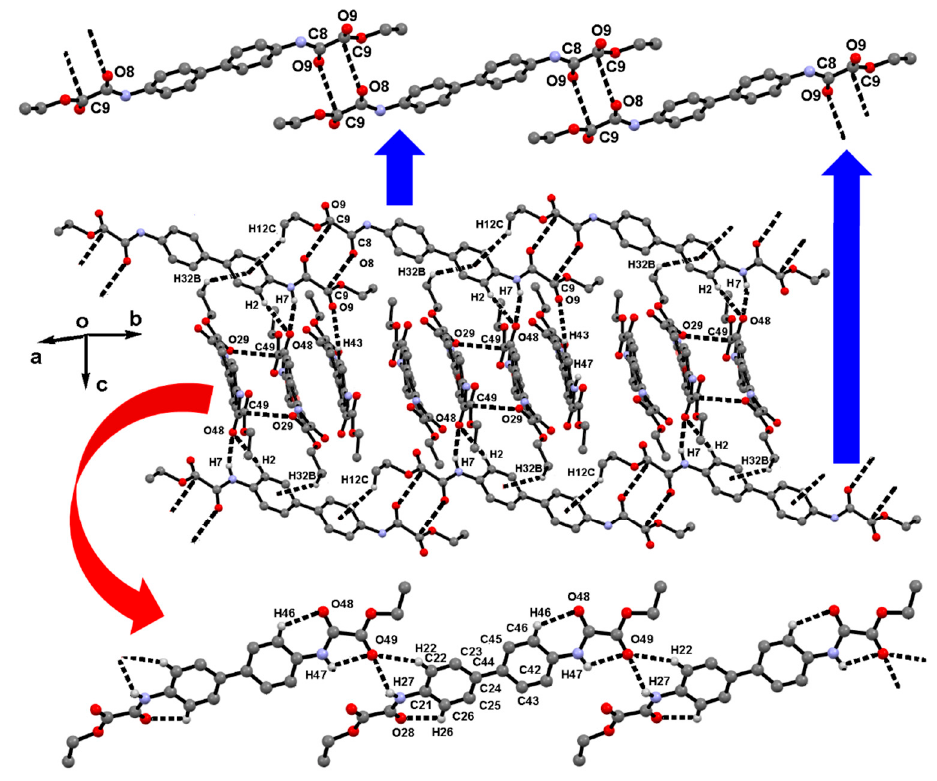
Figure 8. Supramolecular sheet of cross linked molecules of 3 formed by the N-H ··· O hydrogen bonds, and C-H ··· O, C-H ··· π and C = O ··· C = O interactions.